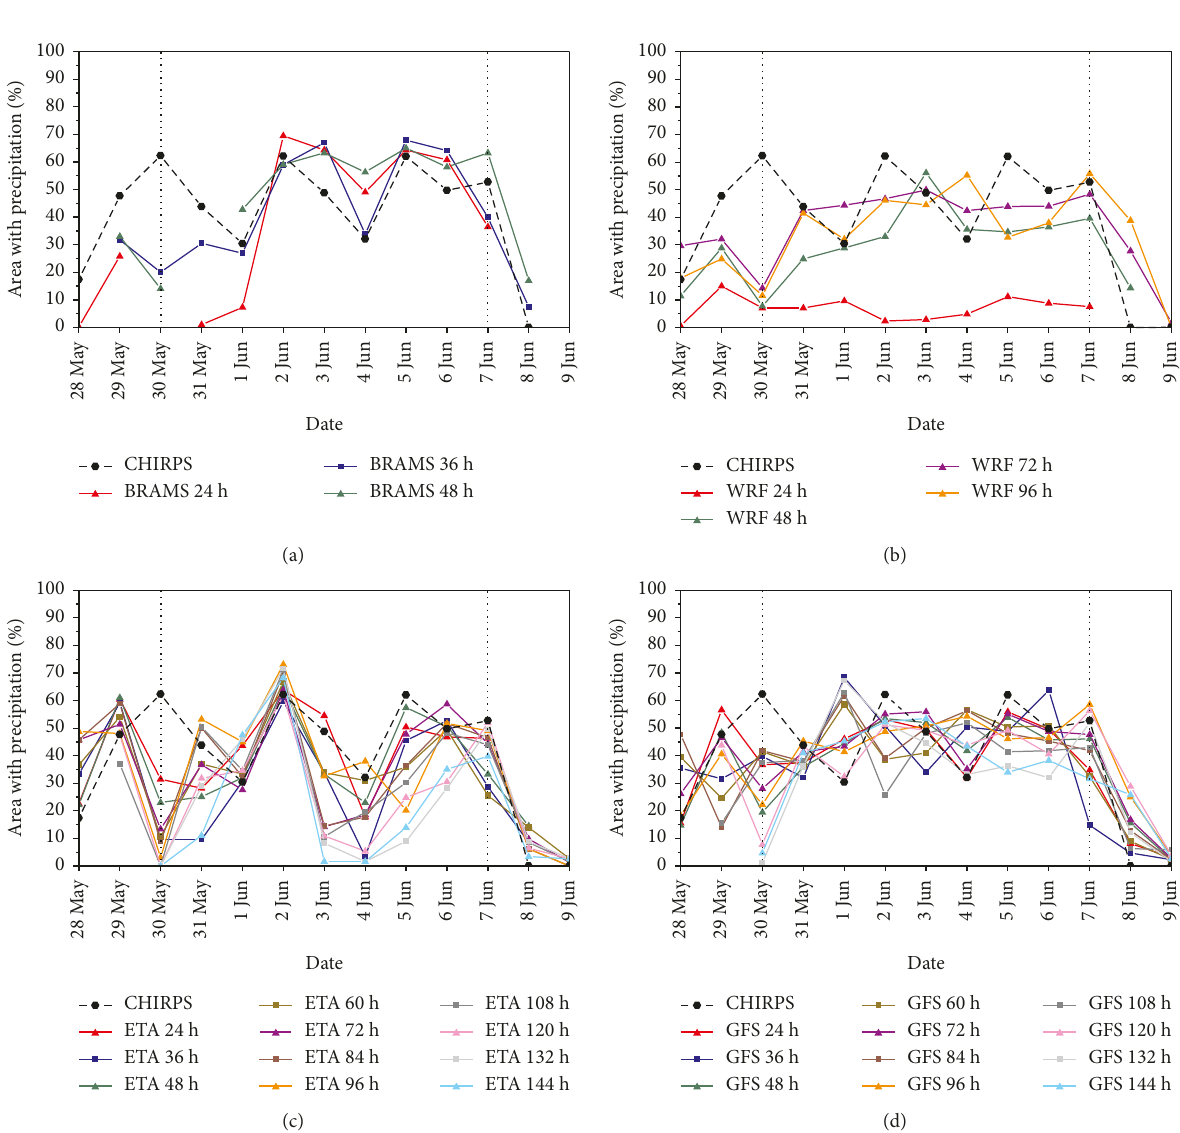
Figure 10: Temporal evolution of the percentage of the SP region area with precipitation above the threshold of 5mm and for different forecast times of the models (a) BRAMS, (b) WRF, (c) Eta, and (d) GFS, from 29 May to 9 June 2016. Dotted lines indicate the start (30 May 2016) and end (07 June 2016) of the period of